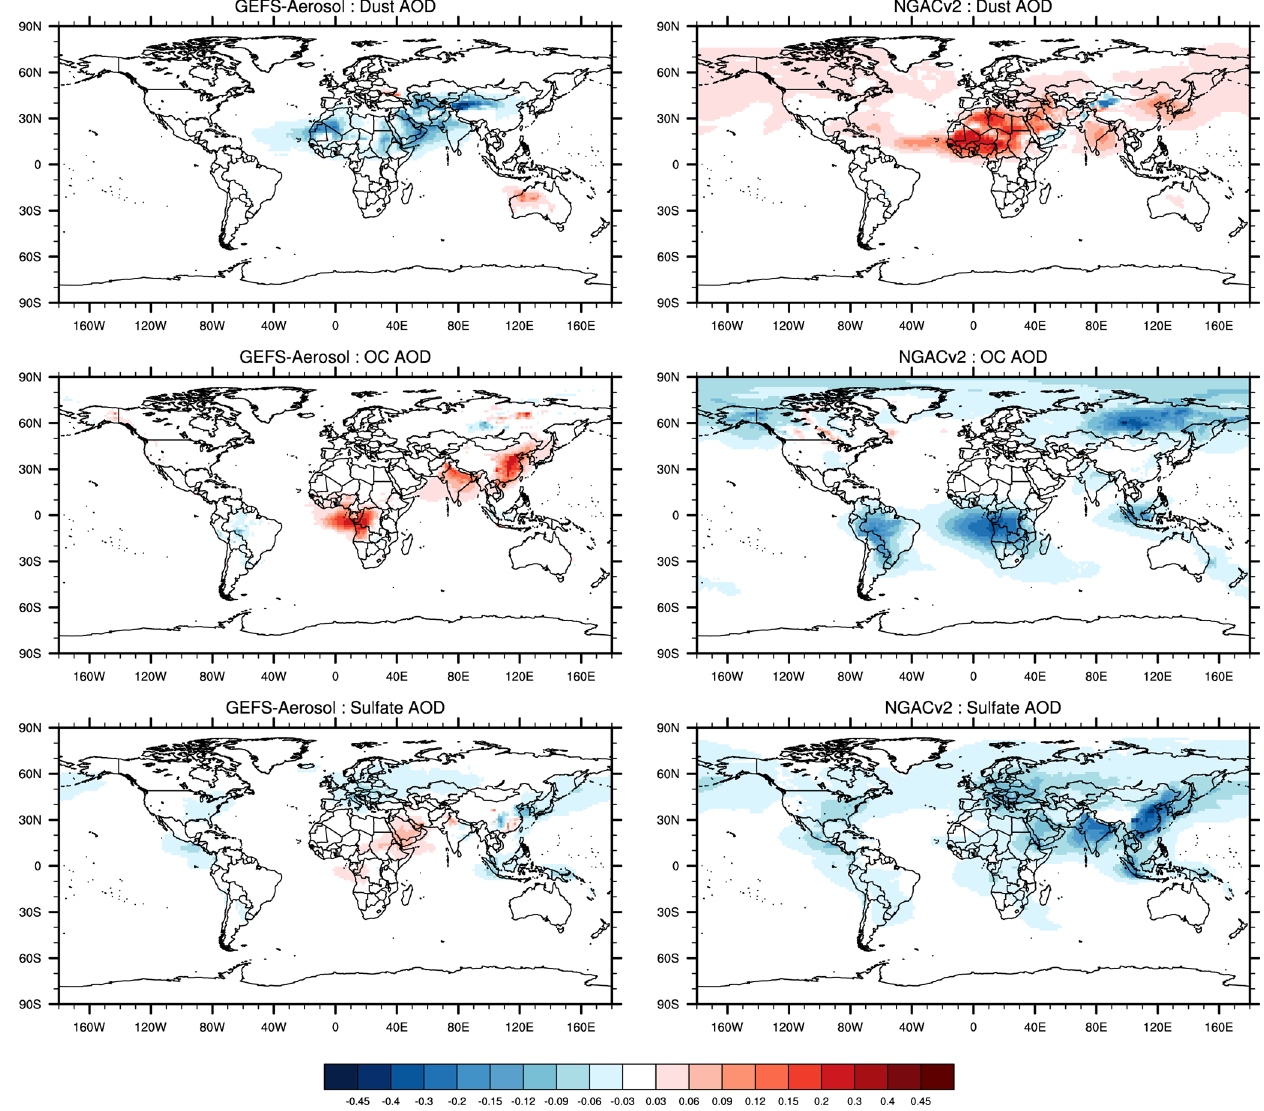
Figure 7. Day-1 AOD forecast biases of GEFS-Aerosols and NGACv2 compared to MERRA-2 averaged during 5 July–30 November 2019 for dust, OC, and